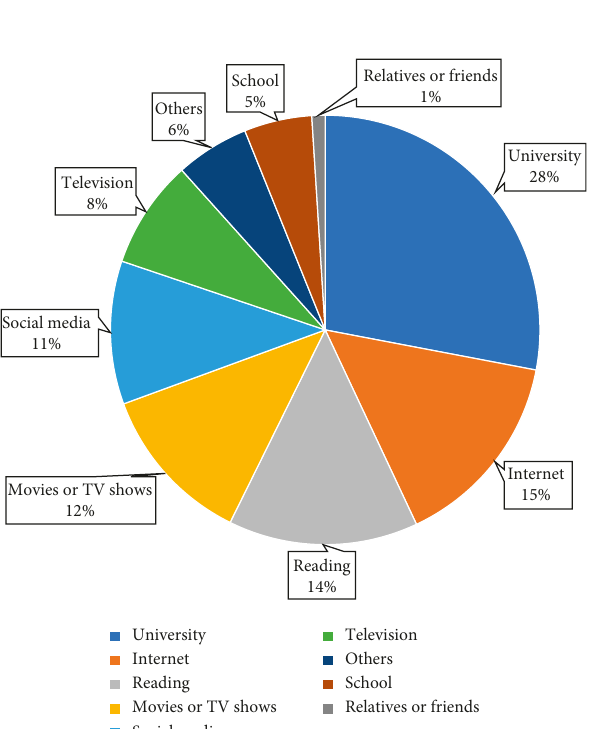
Figure 4: The sources of CPR knowledge.